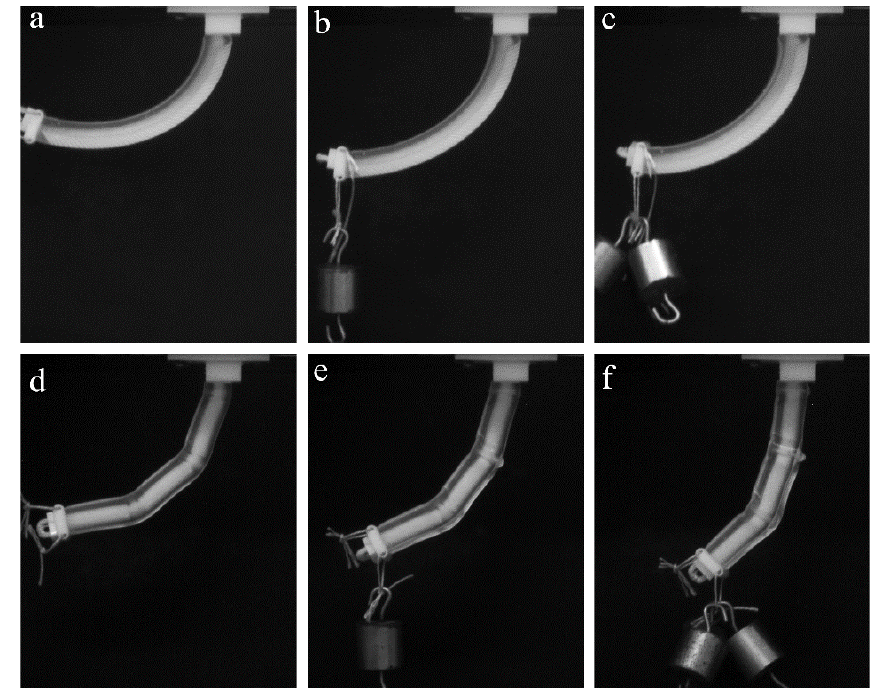
Figure 9. Experimental snapshot for TangoPlus actuators with periodic stiff inclusions (“scales”) ( a – c ) and stiff tubular sections around cable channel ( d – f